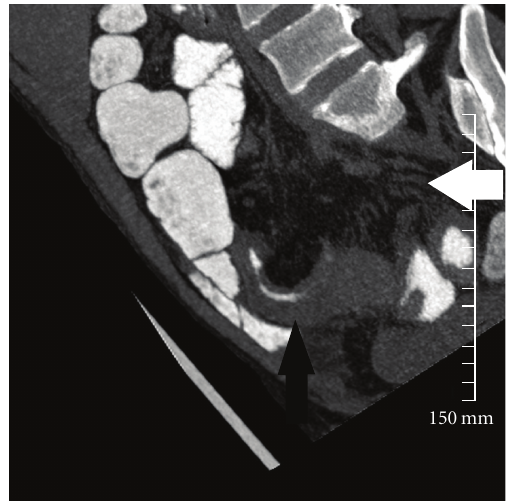
Figure 1: 38-year-old patient with Crohn’s disease with 8mm thick slab reconstruction in coronal-oblique plane. There is mural thickening of the ileum (black arrows), increased mesenteric fat attenuation, and prominence of the vasa recta (white arrowhead), all in keeping with active disease superimposed on chronic changes.